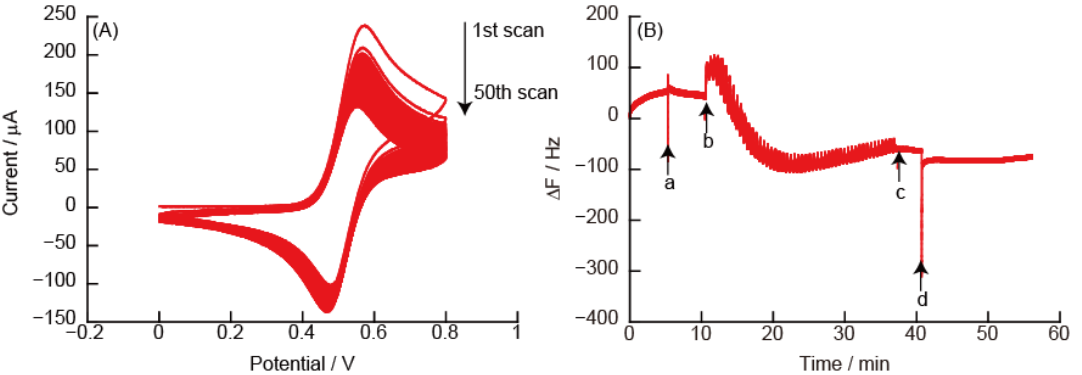
Figure 7. ( A ) Cyclic voltammograms of (PEI/PAA) 5 film in 10 mM TEMPO solution, and ( B ) changes in the resonance frequency on the Au resonator in the eQCM. During QCM measurements, the Au resonator was exposed in (a) 10 mM TEMPO solution and (d) working buffer. The electric potential (scan rate: 50 mV/s, number of sweep scan: 5 cycles) was applied between (b) and (c) in the eQCM.